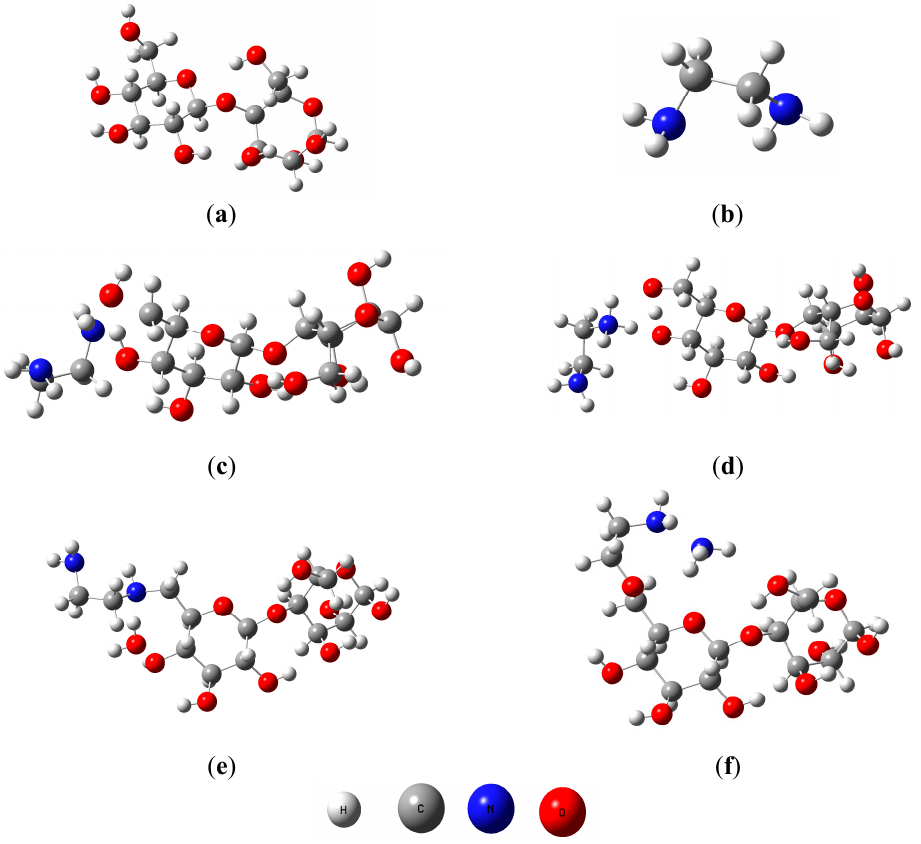
Figure 5. Geometries of cellulose dimer ( a ); ethylenediamine ( b ); transition states (TS A , ( c ) and TS B , ( d )) and products (P A ( e ) and P B ( f )).